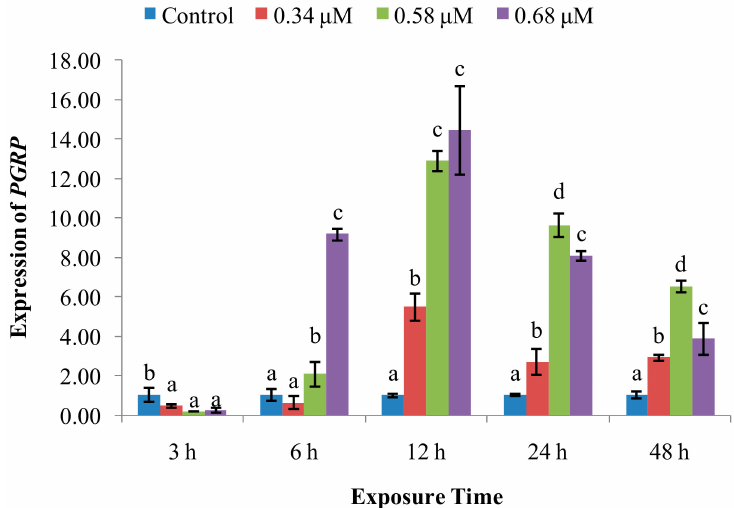
Figure 8. E ff ect of TD 49 on hemolymph expression of PGRP at di ff erent time points after exposure to di ff erent concentrations (0, 0.34, 0.58, 0.68 µ M) of TD 49 . Data represent mean ± SD values ( n = 3) at the same time interval, with di ff erent letters denoting significant di ff erences ( p < 0.05).